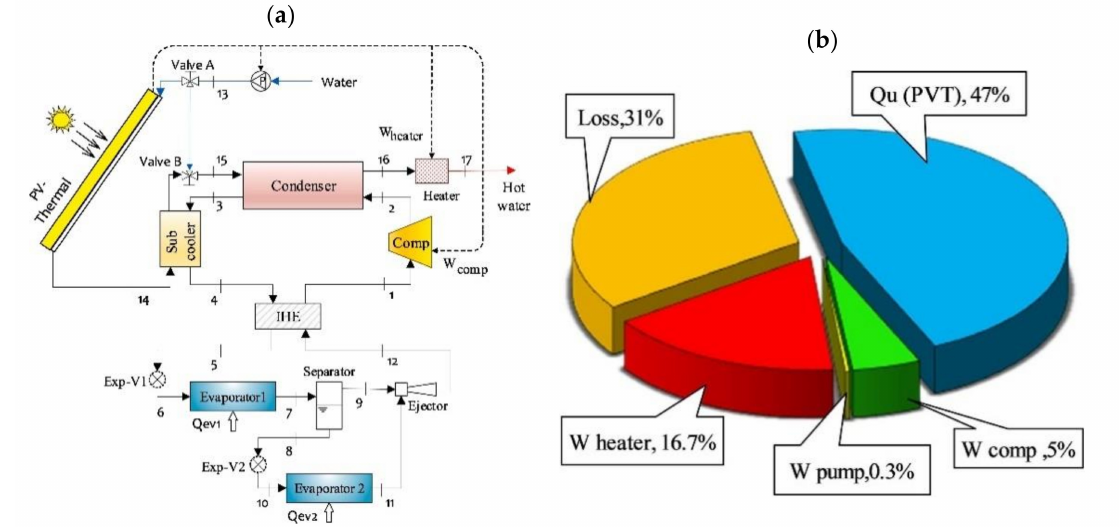
Figure 13. ( a ) Schematic of the system; ( b ) distribution of energy incident on PVT from the Sun at irradiation = 945 Wm − 2 and water mass flow rate = 0.013 kg/s (reprinted from [92], with permission from publisher).